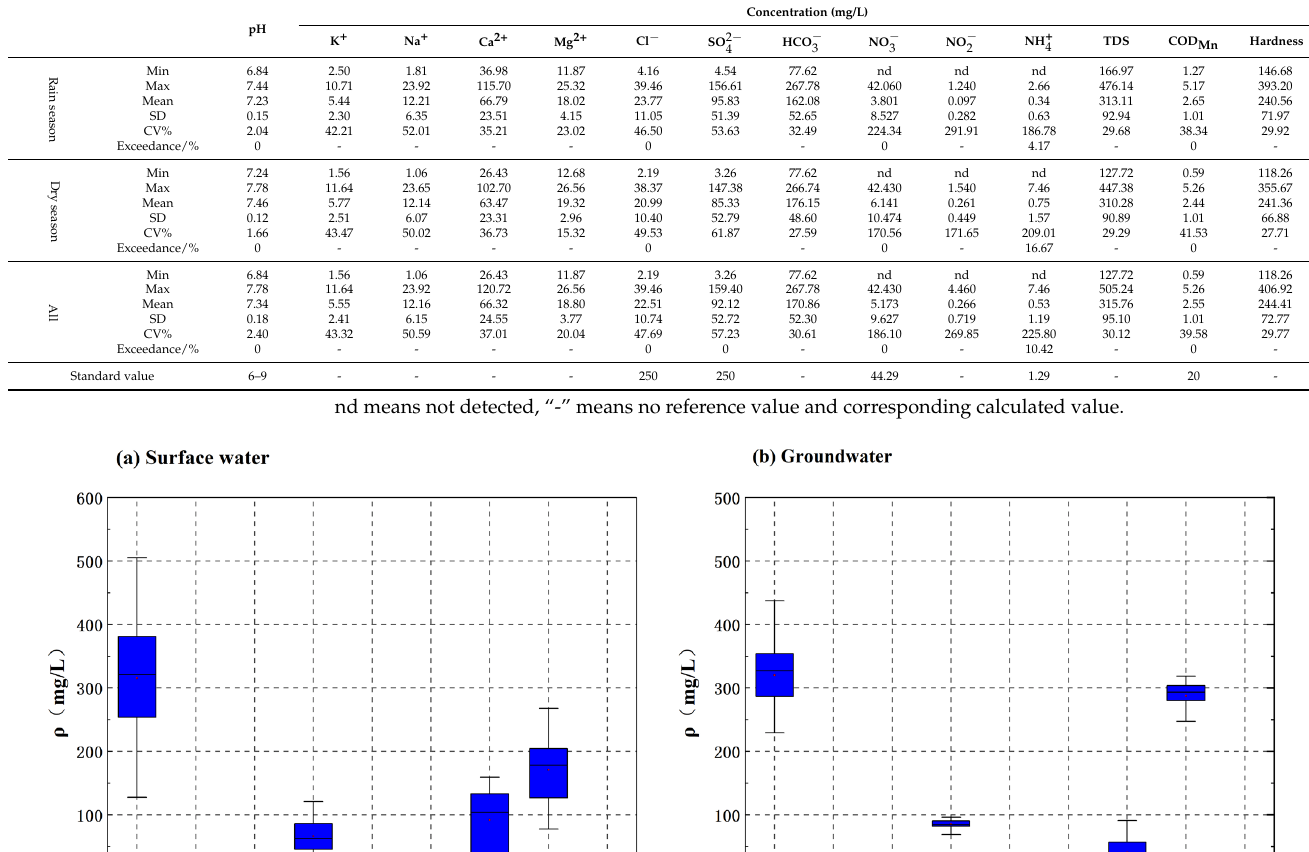
Table 2. Statistics of water chemistry parameters in surface water (N = 48).